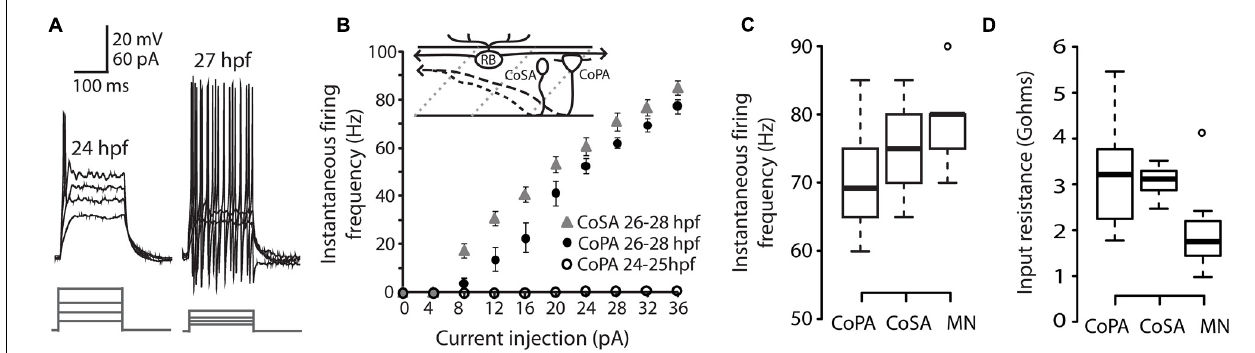
FIGURE 1 | Intrinsic properties of embryonic commissural primary ascending (CoPA) interneurons are similar to other spinal neurons. (A) Representative current injections showing single vs. burst firing of action potentials in CoPAs at 24 and 27 hours post-fertilization (hpf), respectively. Upper traces, current-clamp recording, lower traces, current steps. Note the reduction in action potential threshold at 27 hpf. (B) Quantification of instantaneous firing frequency (Hz) vs. current injection (pA) for CoPA and CoSA neurons in 26–28 hpf embryos ( N = 9, 9) and CoPA neurons in 24–25 hpf embryos ( N = 5). Inset shows the